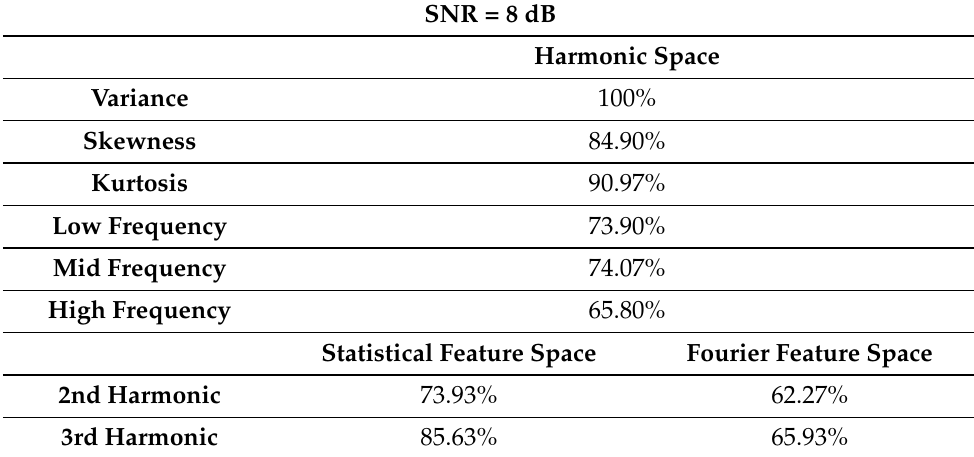
Figure 18. Classification performance via Fourier features in [9]: ( a ) classification performance via Fourier features for each frequency level in harmonic space [9] and ( b ) classification performance via Fourier features for each harmonic [9]. Table 6. Comparison table for all classification performances at SNR = 8